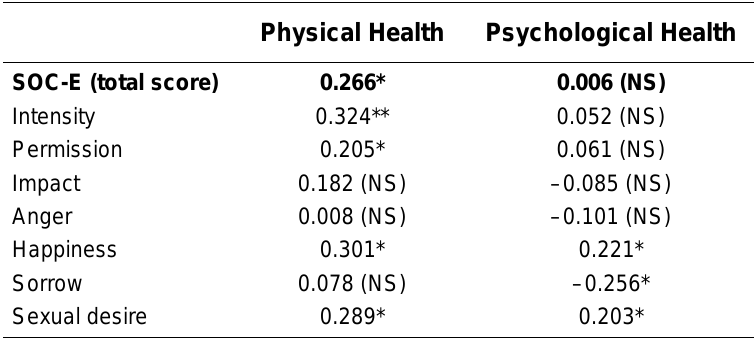
Pearson Correlation Coefficients Between SOC-E and Health Measures